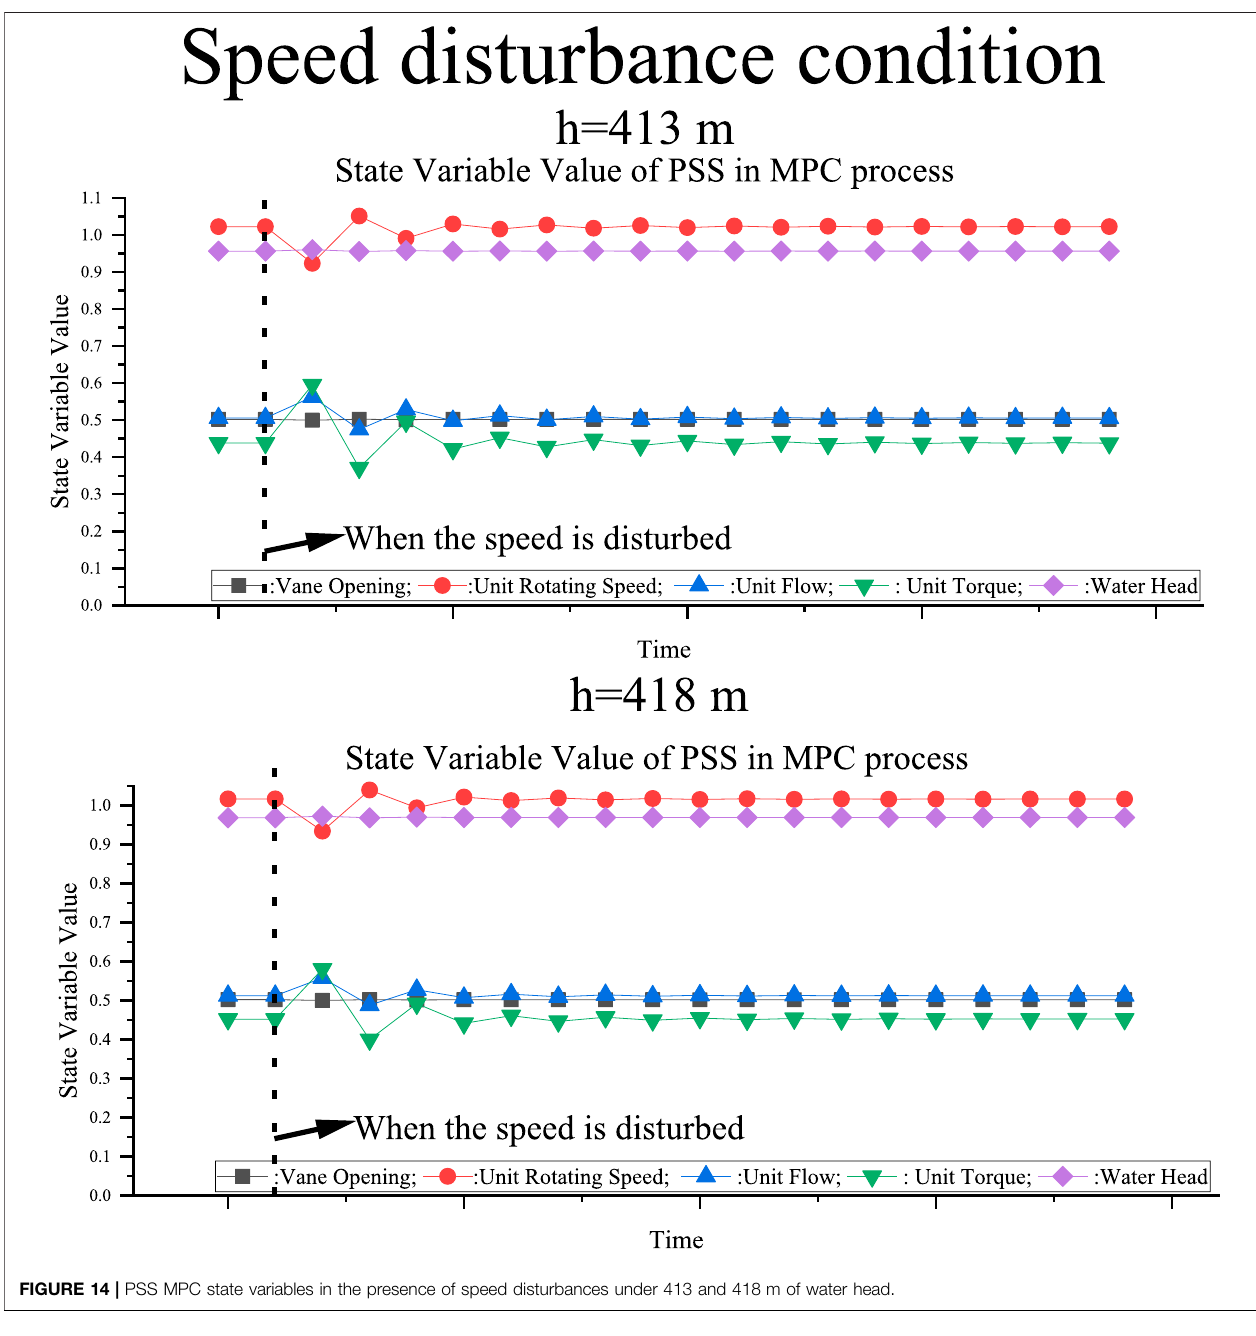
Frontiers in Energy Research |